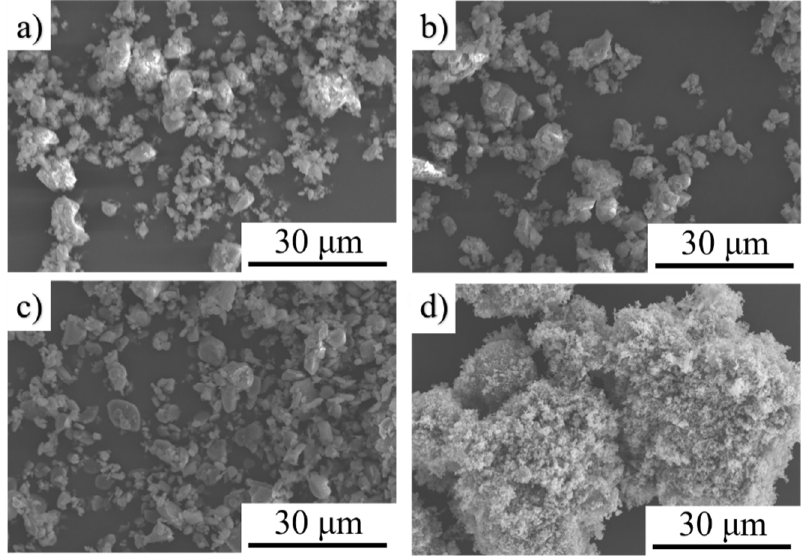
Figure 1. SEM micrographs of as-received powders: ( a ) Si 3 N 4 , ( b ) AlN, ( c ) Al 2 O 3 , ( d ) TiO 2 .